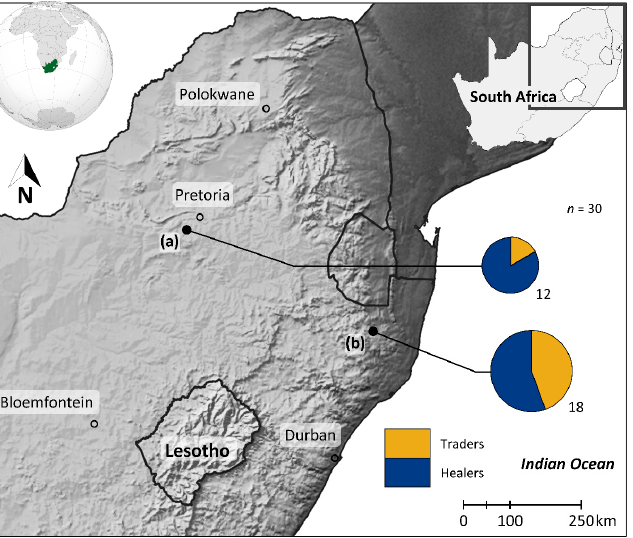
Figure 1. The study area in eastern South Africa where traditional muthi market traders ( n = 10; yellow) and healers ( n = 20; blue) were interviewed at ( a ) Faraday ( n traders = 2; n healers = 10) and ( b ) Mona markets ( n traders = 8; n healers = 10) between September and November 2019.